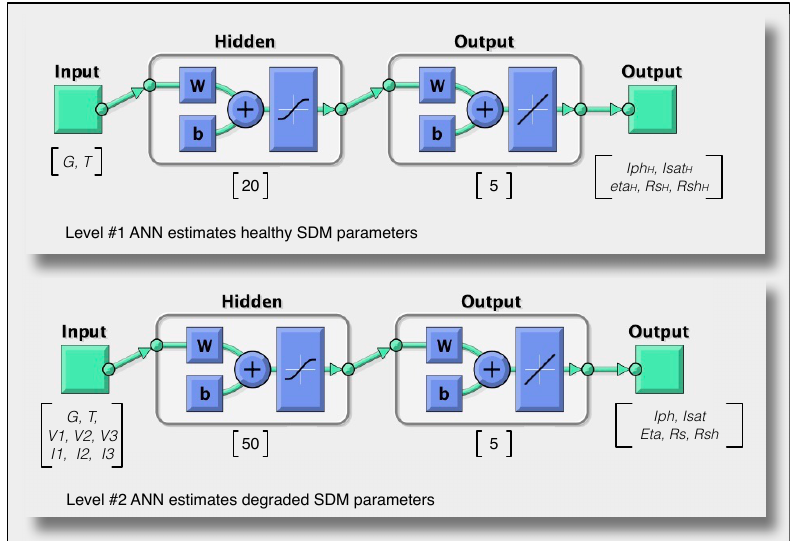
Figure 5. Proposed ANN